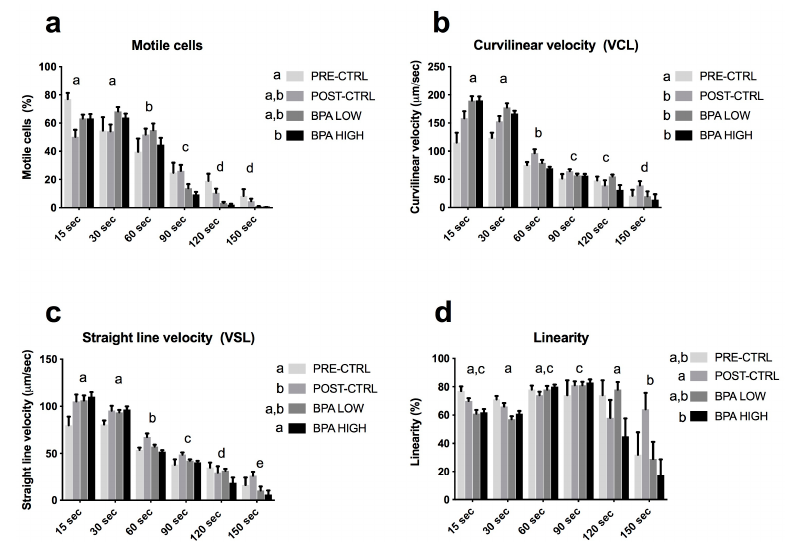
Figure 2. Computer-Assisted Sperm Analysis (CASA) of gilthead sea bream milt. Mean ± SEM of ( a ) ( a ) percentage of motile cells; ( b ) VCL as µ m / sec; ( c ) VAP as µ m / sec; ( d ) VSL as µ m / sec and ( e ) linearity in percentage (%). Statistically significant di ff erences (two-way ANOVA, Tukey’s post hoc test, p < 0.05) are indicated by di ff erent letter superscripts among treatments (in the legend, next to the experimental groups) and sample times (above the columns).